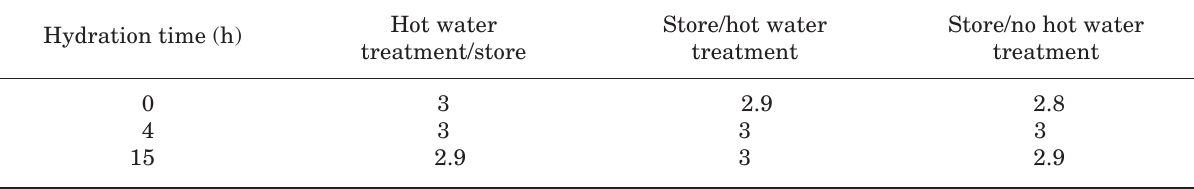
Table 4. Cultivar Cabernet Sauvignon - means of final condition scores where 1, dead; 2, “B” grade; 3, “A” grade. Hydration time